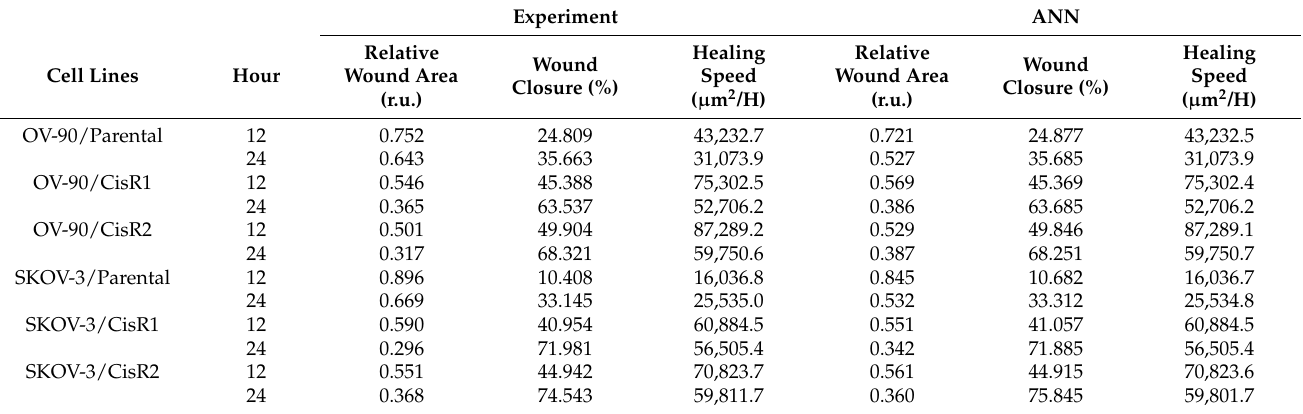
Table 7. The comparison between experimental and predicted ANN results for testing data. Experiment ANN Cell